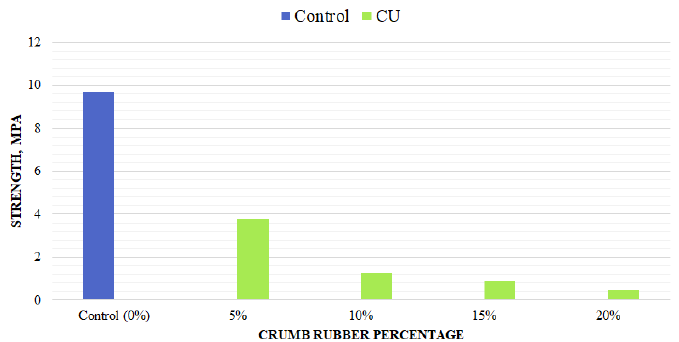
Figure 11. Compressive strength (after heating) at 28 days